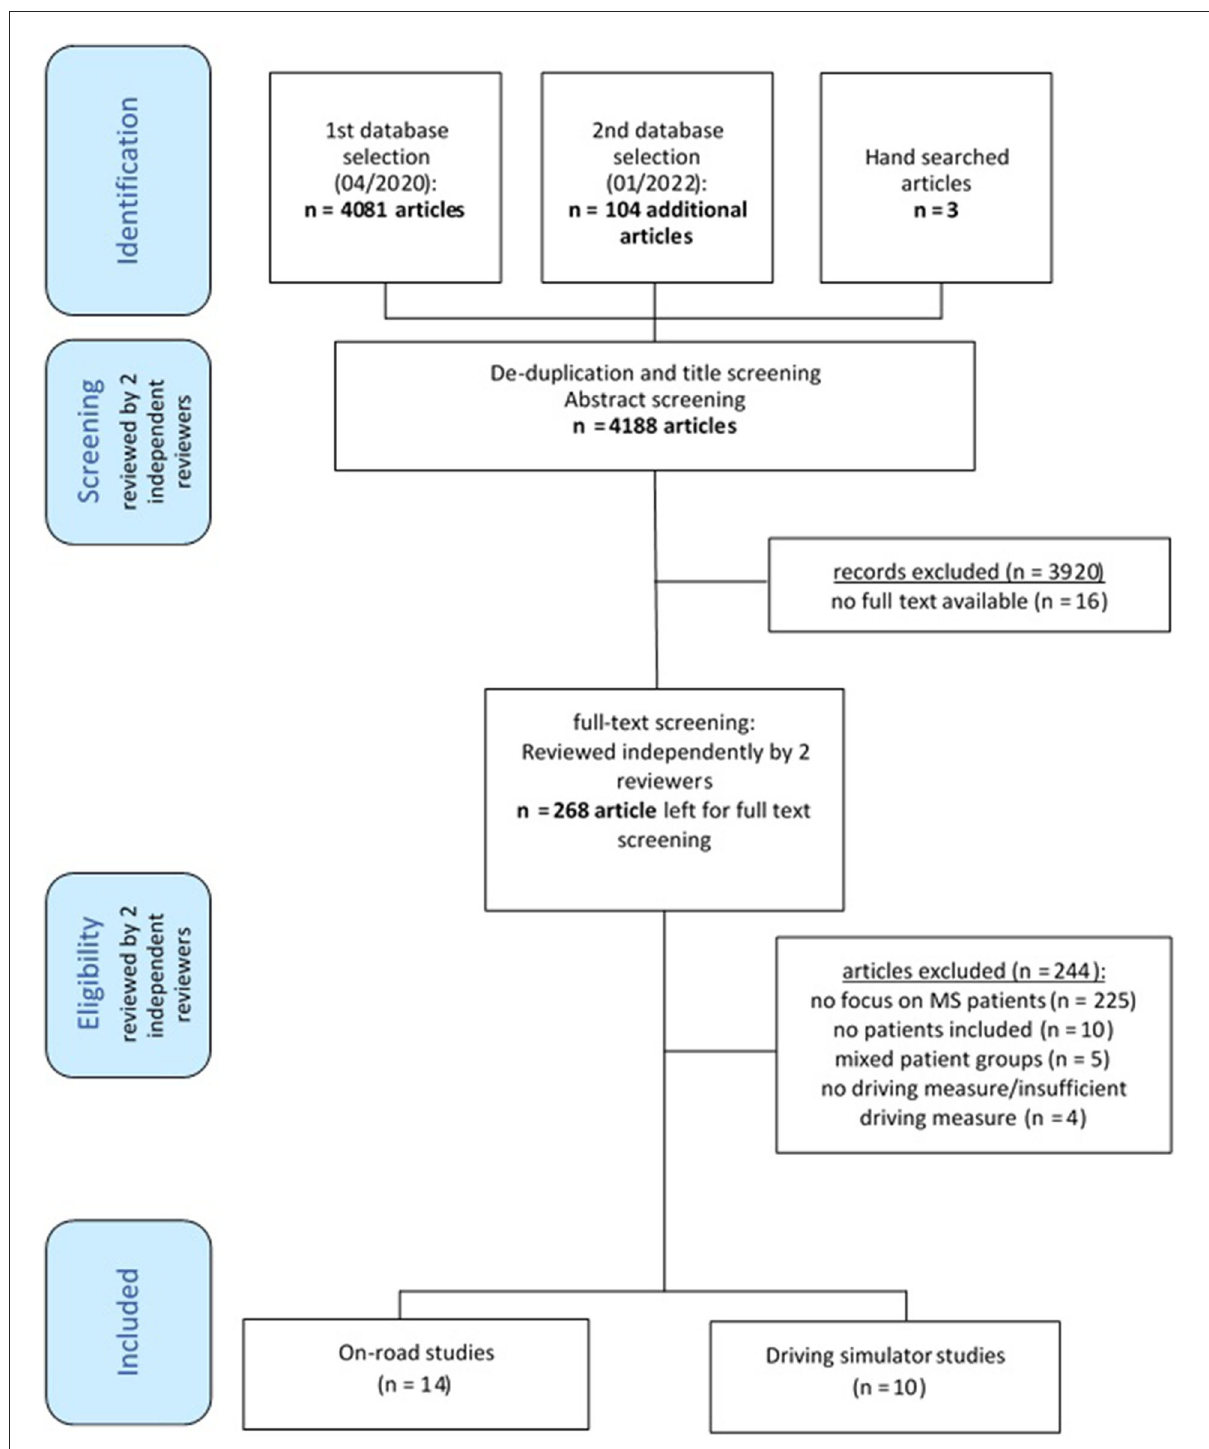
FIGURE1 Flow diagram of all included studies.